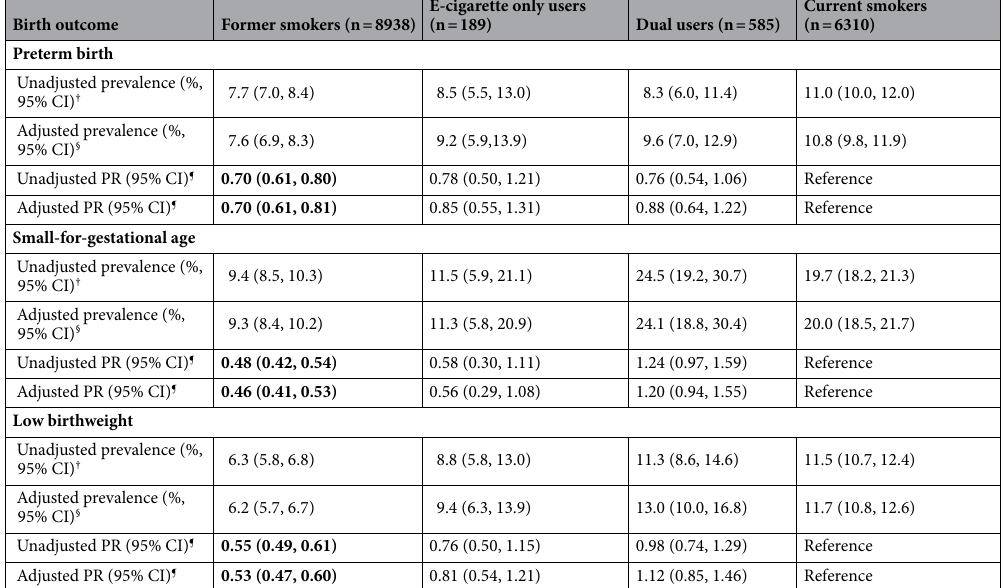
estimated from the weighted percentage and corresponding 95% confidence intervals. ‡ Adjusted prevalence calculated as the average marginal predictive values. ¶ Unadjusted and adjusted prevalence ratio of birth outcome and corresponding 95% confidence interval. Adjusted prevalence ratios control for by maternal age, race/ethnicity, adequacy of prenatal care (based on the Adequacy of Prenatal Care Utilization (APNCU) Index), parity, multivitamin use, and presence of an obstetric risk